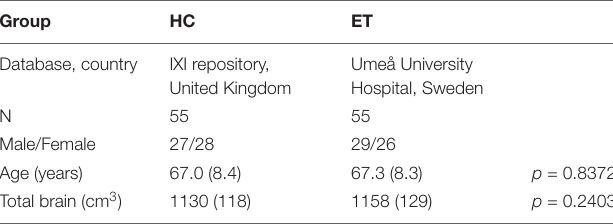
TABLE 1 | Subject characteristics and total brain volumes from